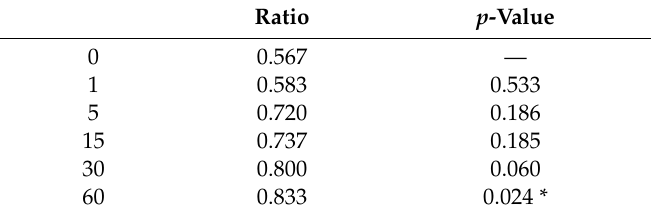
Table 2. E ff ect of catechin ingestion on long-term memory of 12-month-old SAMP10